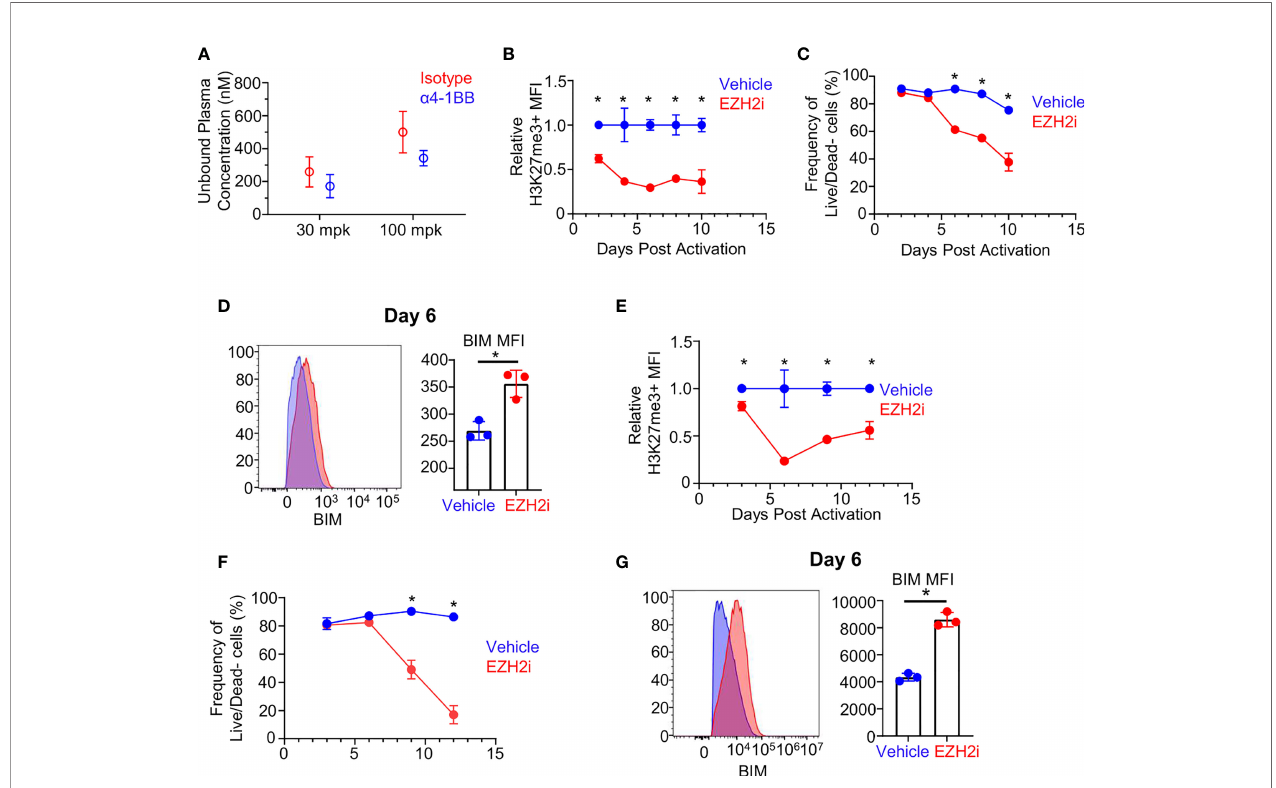
FIGURE 4 | Effect of EZH2i on BIM expression and effector survival is CD8 + T cell intrinsic. Biologically relevant exposure of in vivo activated CD8 + T cells was determined by calculating the free unbound plasma concentration of EZH2i (A) (from mice in Figure 2 ) at 3 hours after treatment on day six post OVA/PolyI:C administration. Using the 100 mpk exposure concentration (~500 nM), isolated and activated murine CD8 + T cells were exposed to EZH2i and the relative reduction in H3K27me3 status (B) and viability (C) were tracked over time. BIM levels were determined on day 6 post activation. Representative histogram ( D , left panel) and pooled data ( D , right panel) are shown. Isolated human CD8 + T cells were activated in vitro and relative reduction of H3K27me3 status (E) and viability (F) were determined. Human BIM levels were determined at day 6 post activation. Representative histogram ( G , left panel) and pooled data ( G , right panel) are shown. Blue indicates vehicle-treated cultures. Red indicates EZH2i treated-cultures at 500 nM (mouse) or 300 nM (human) concentrations. Gaussian distribution was determined by normality test and subsequent appropriate statistical test, unpaired student ’ s t-test or Mann-Whitney U, was performed to determine signi fi cance. Asterisks (*) indicated signi fi cant fi ndings; p ≤ 0.05. For (A – D) , results representative of 2 independent